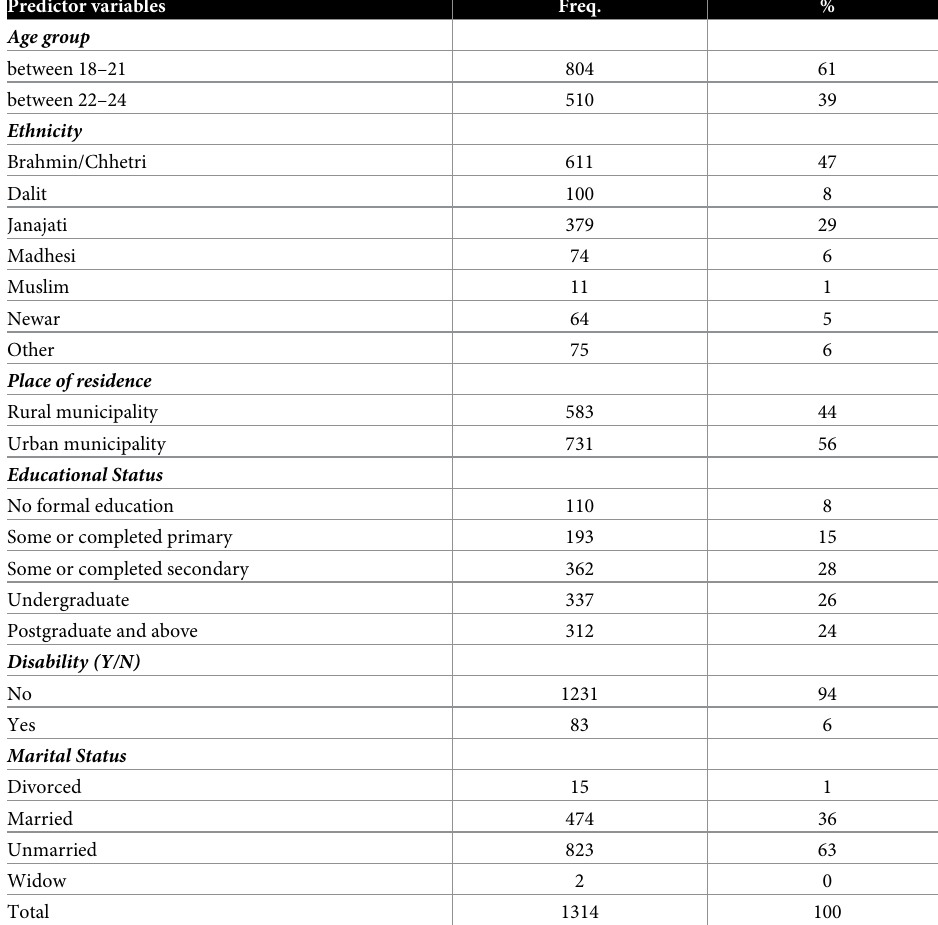
Table 2. Socio-demographic characteristics of the participants. Predictor variables Freq.